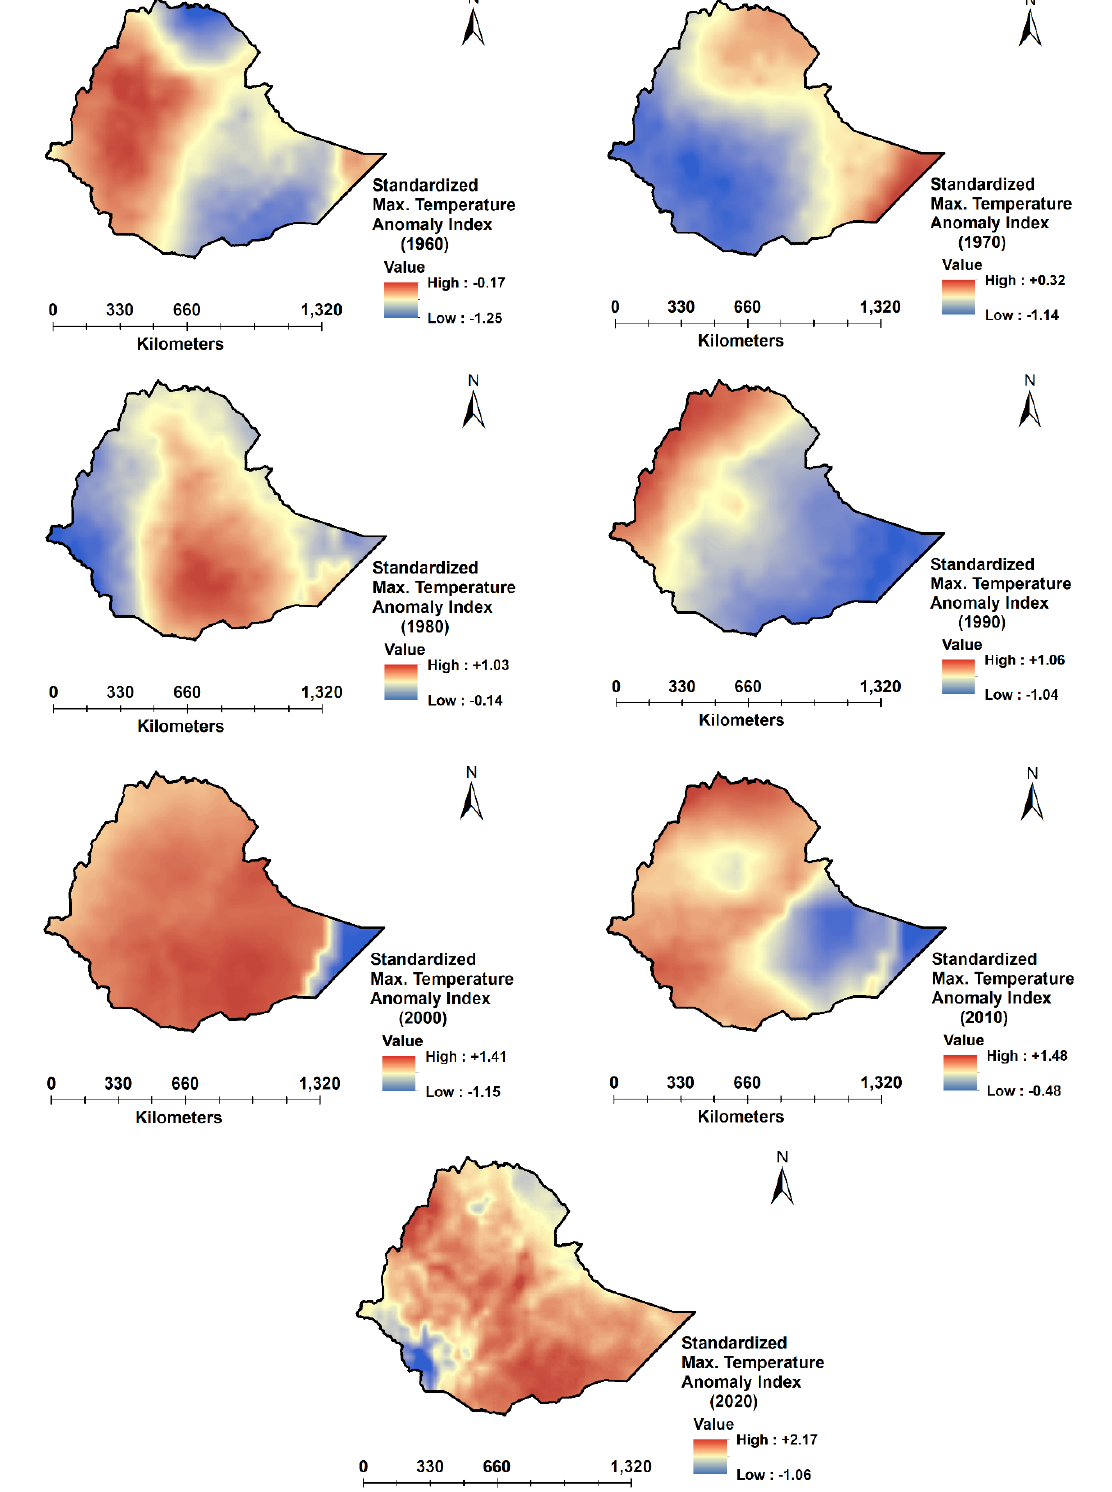
Figure 5. Standardized max. temperature anomaly index maps for 1960, 1970, 1980, 1990, 2000, 2010, and 2020 in the study of Ethiopia.